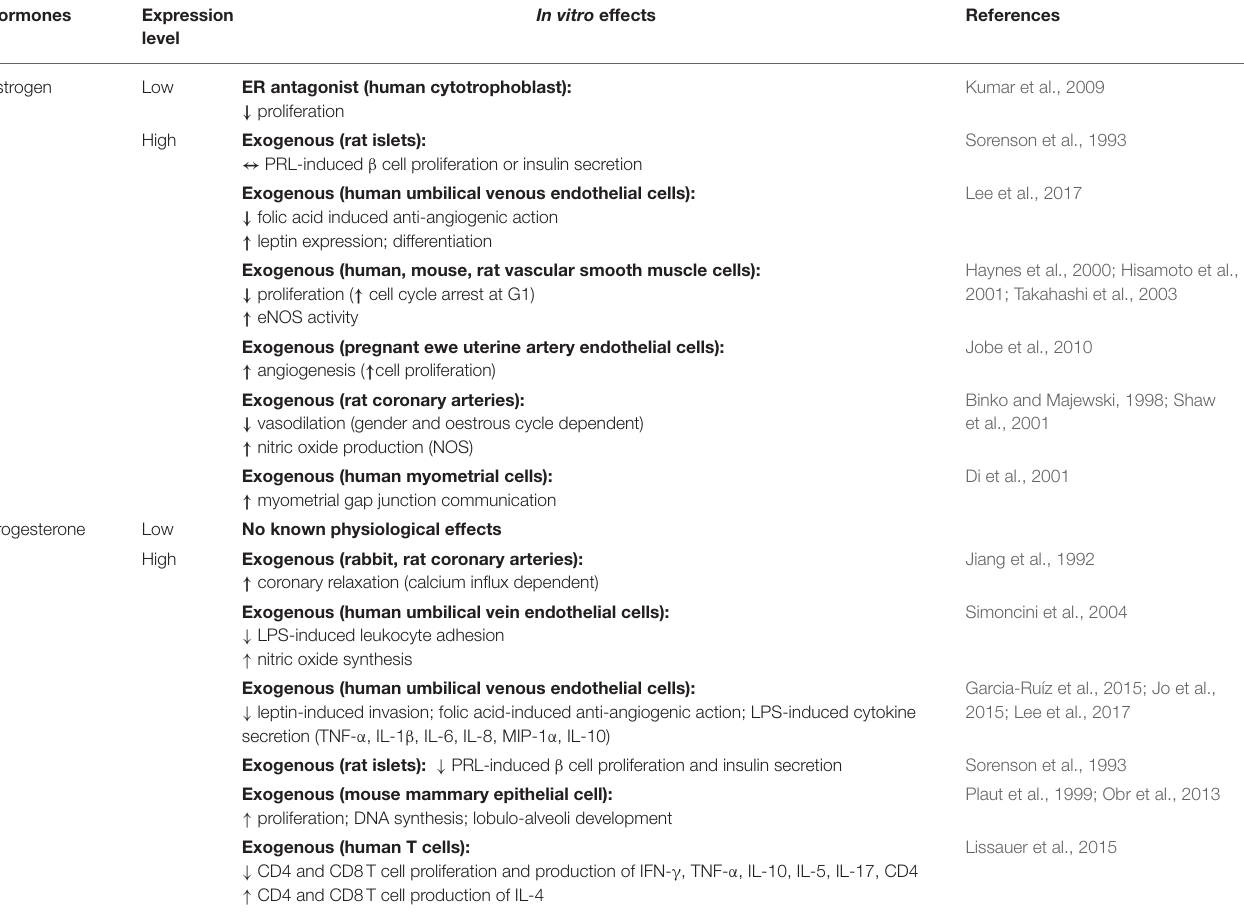
TABLE 4 | Effects of steroid hormones in vitro .